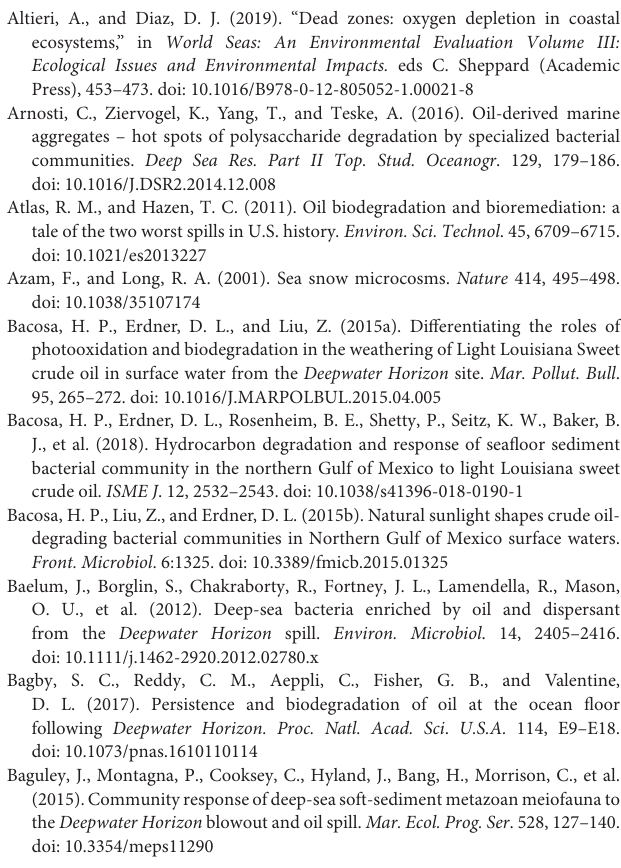
Supplementary Figure 1 | Phylogenetic tree based on 16S rRNA sequences for different species of the family Colwelliaceae. The 16S rRNA sequence of Colwellia RC25 which was isolated from marine oil snow (MOS) particles in Baelum et al. (2012) is highlighted in bold. The evolutionary history was inferred using the Neighbor-Joining method. The percentage of replicate trees in which the associated taxa clustered together in the bootstrap test (1,000 replicates) are shown next to the branches. The tree is drawn to scale, with branch lengths in the same units as those of the evolutionary distances used to infer the phylogenetic tree. The evolutionary distances were computed using the Maximum Composite Likelihood method and are in the units of the number of base substitutions per site. Evolutionary analyses were conducted in MEGA